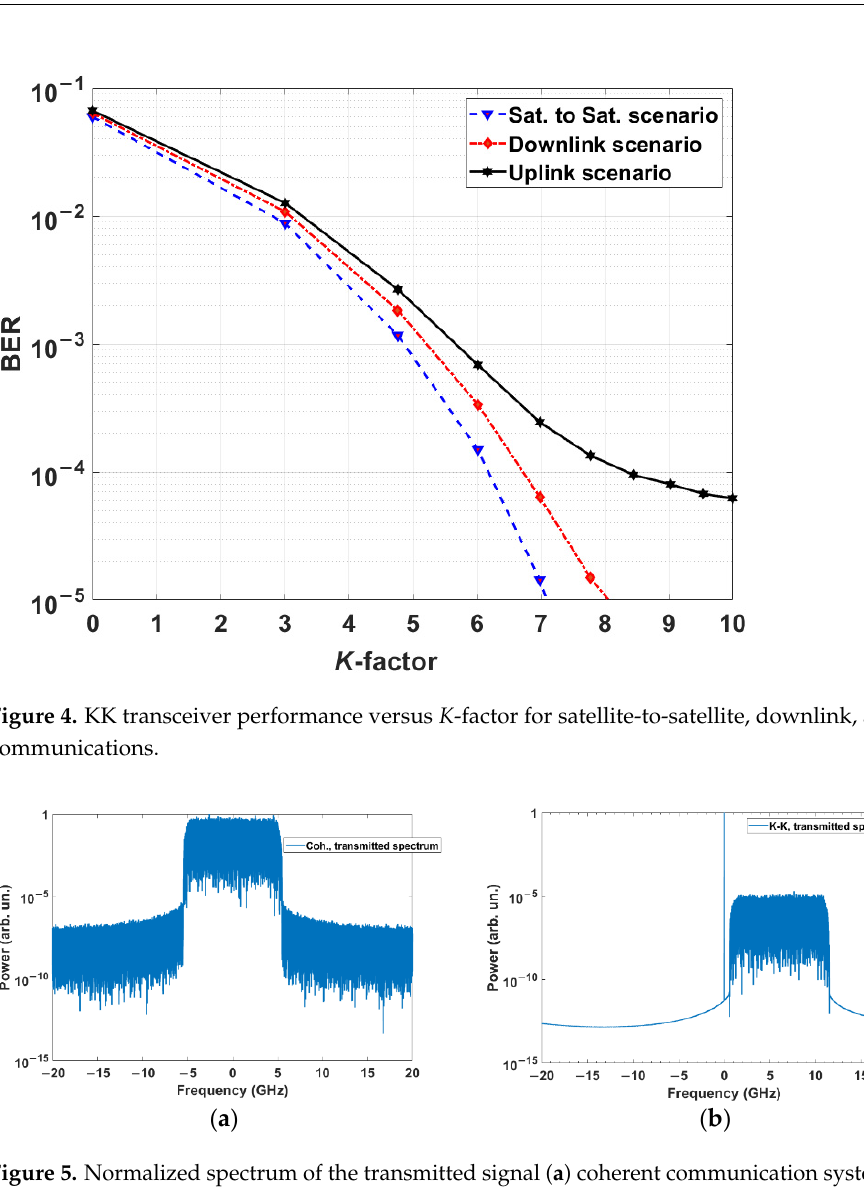
Figure 5. Normalized spectrum of the transmitted signal ( a ) coherent communication system, and ( b ) KK communication system ( K = 10).